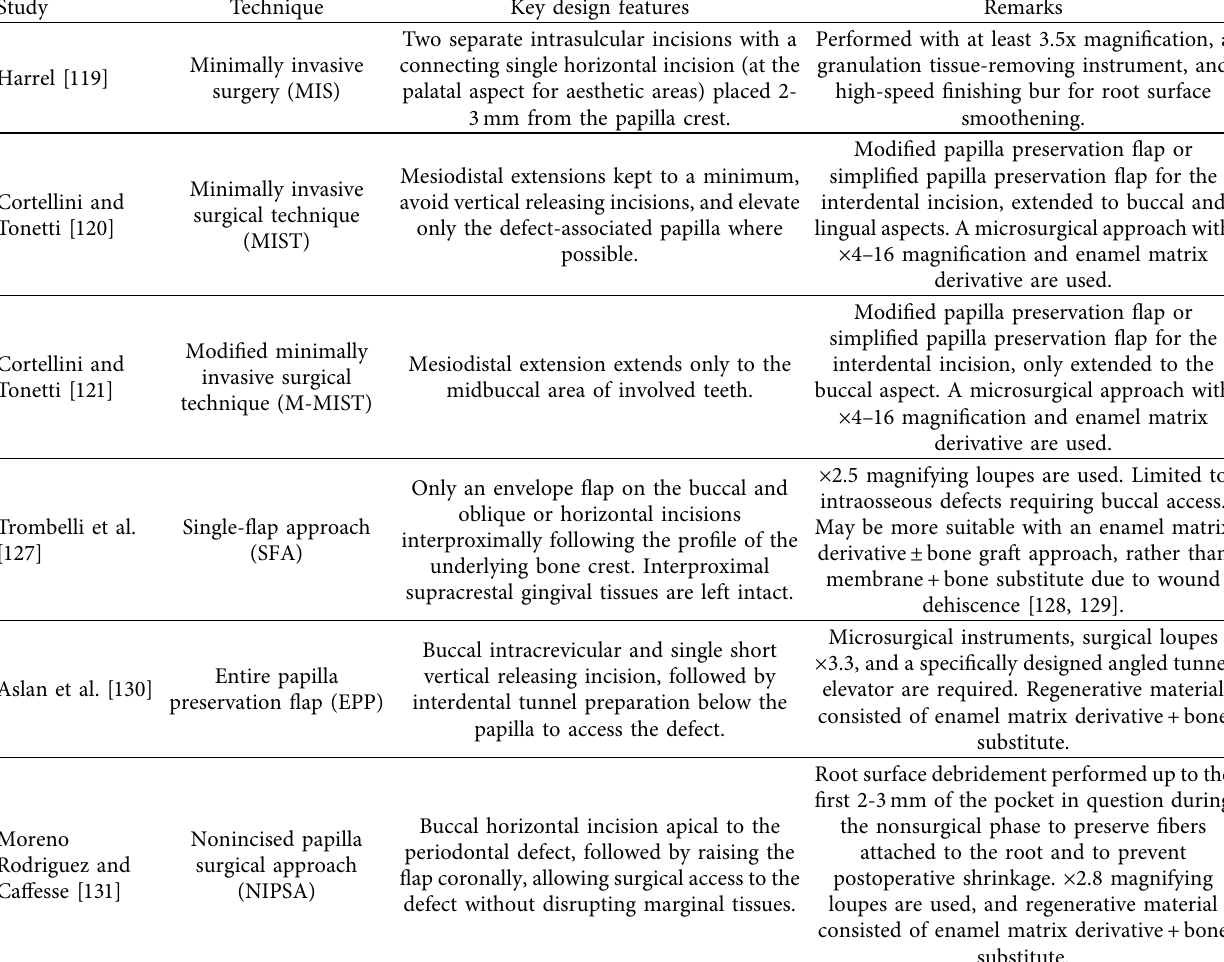
Table 1: Various designs for a minimally invasive surgery to facilitate wound stability and improved regenerative outcomes. Study Technique Key design